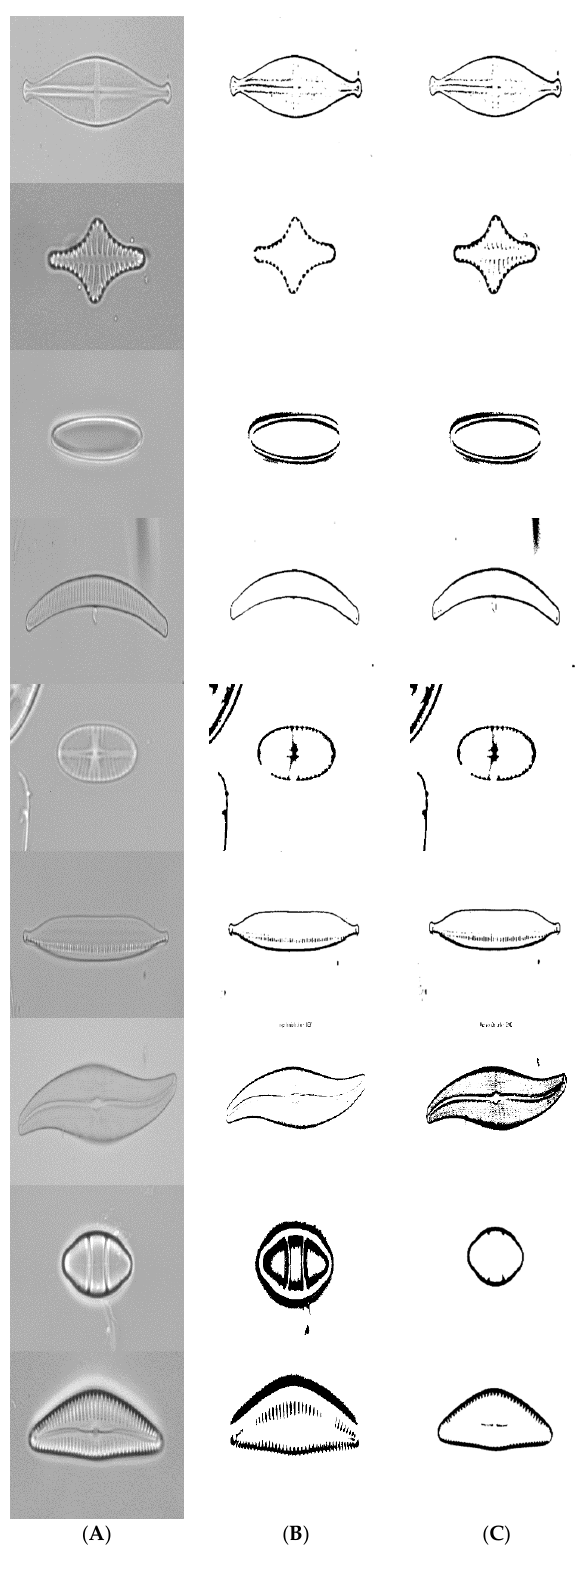
Figure 9. The thresholding results by using the PST and Otsu techniques: ( A ) original images; ( B ) segmented images using the TSP approach ( (cid:1872) ); ( C ) segmented images using the Otsu technique ( (cid:1872) (cid:2925) ).